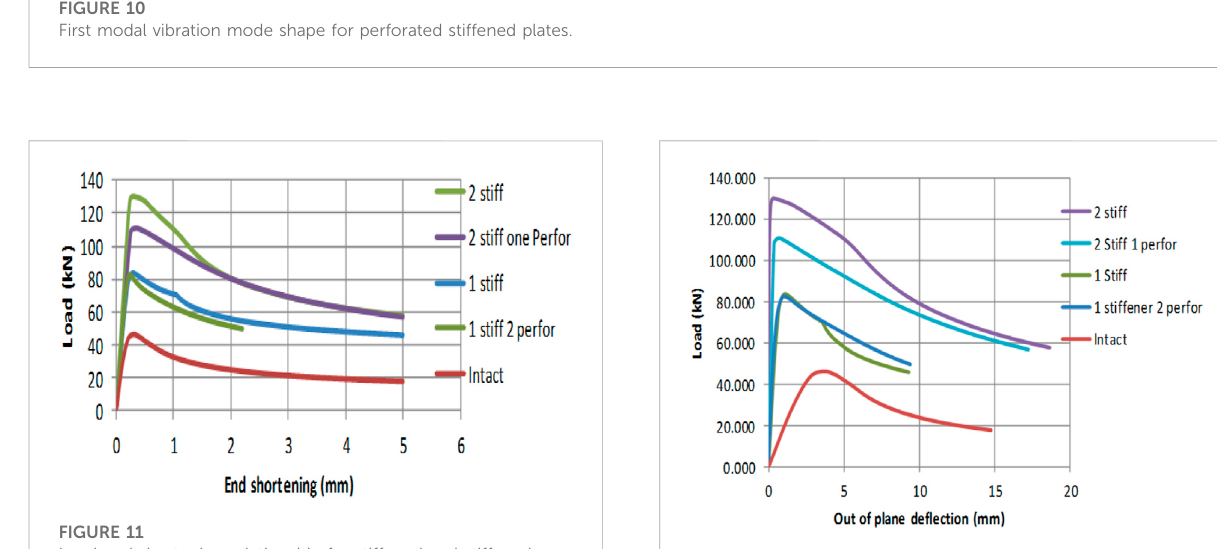
FIGURE 12 Load buckling relationship for stiffened and stiffened perforated compared with the intact